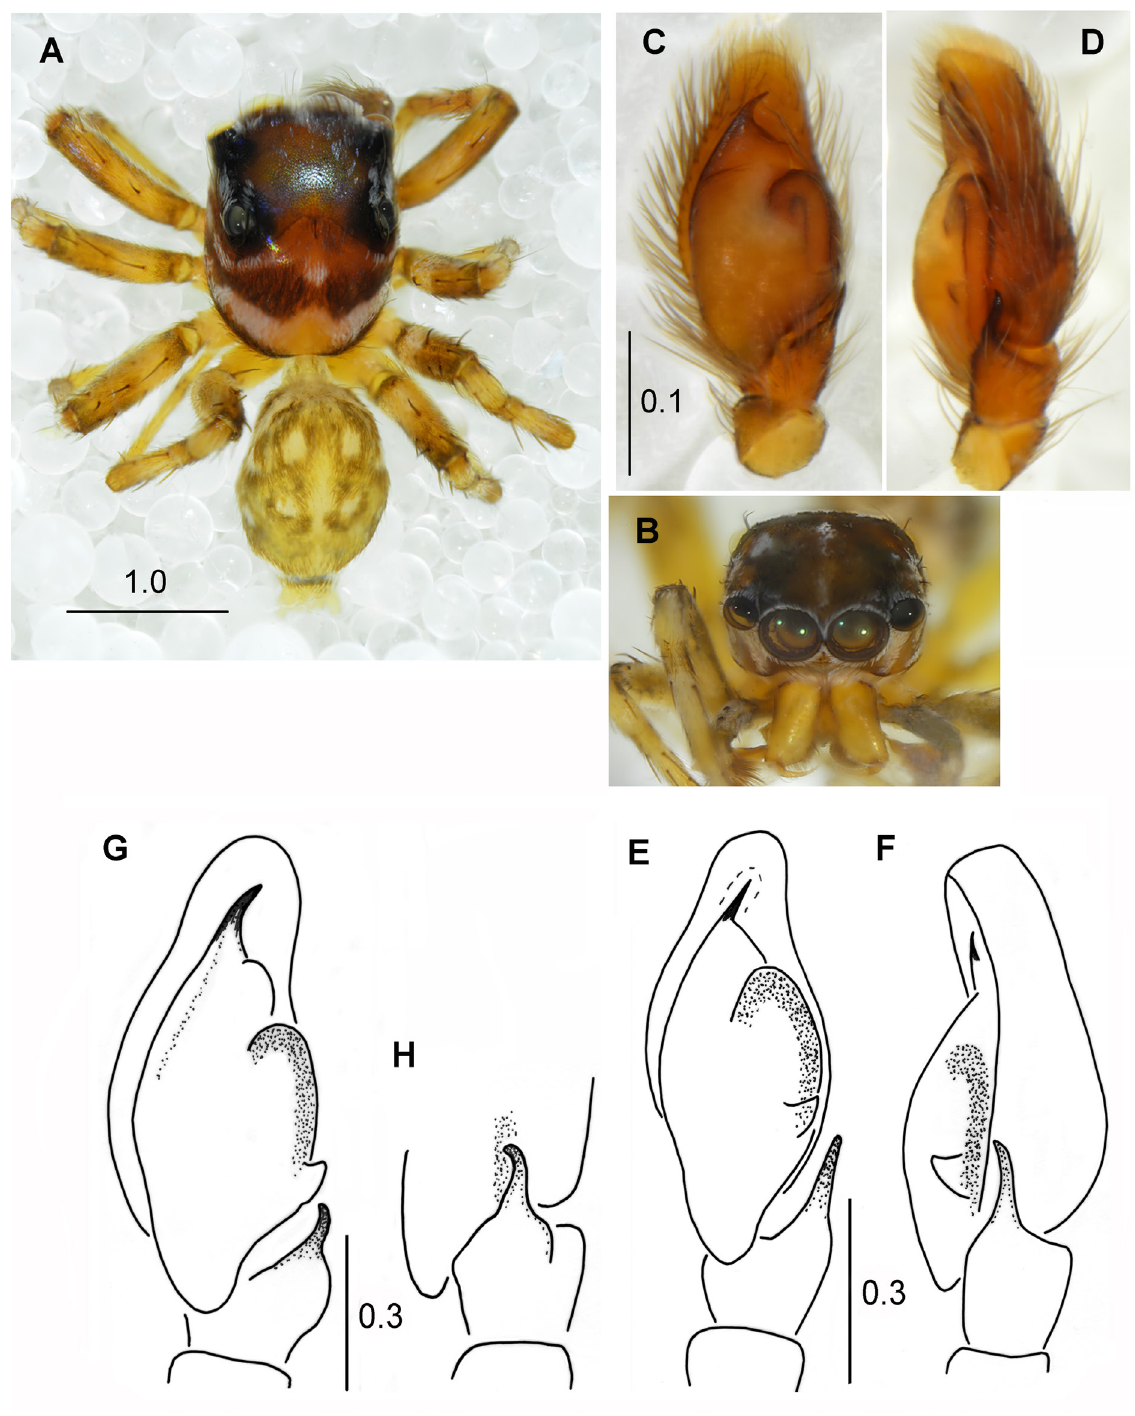
Fig. 45. A–F . Phintella minor (Lessert, 1925) stat. nov., ♂ (MNHN). G–H . Phintella aequipes (Peckham & Peckham, 1903), ♂ (MNHN). A . Habitus, dorsal view. B . Frontal view. C, E, G . Palpal organ, ventral view. D, F . Palpal organ, lateral view. H . Tibial apophysis, lateral